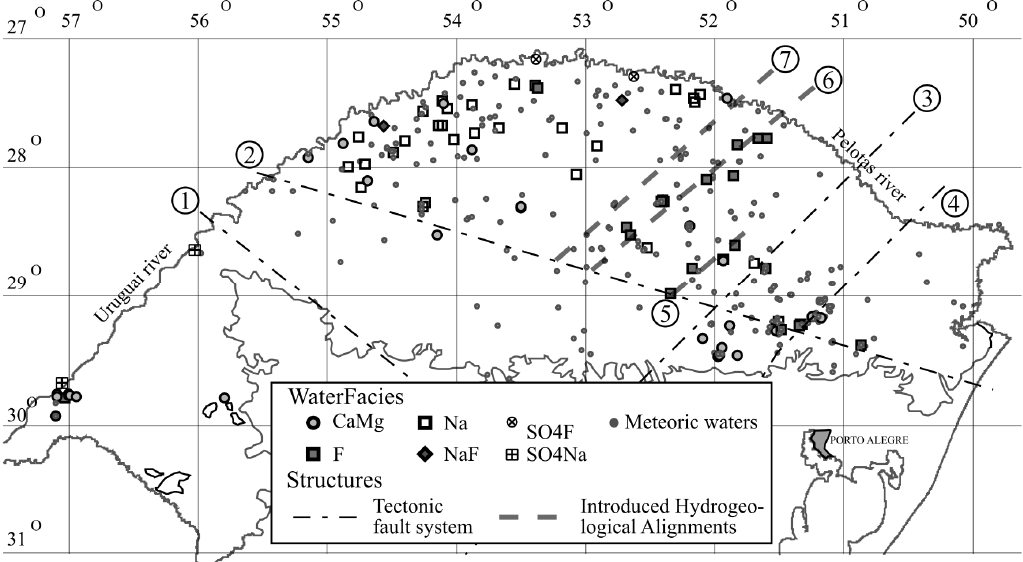
Fig. 3 – Water facies distribution and tectonic fault systems: (1) Mata-Jaguari, (2) Terra de Areia-Posadas, (3) Perimpo, and (4) Leao. Introduced